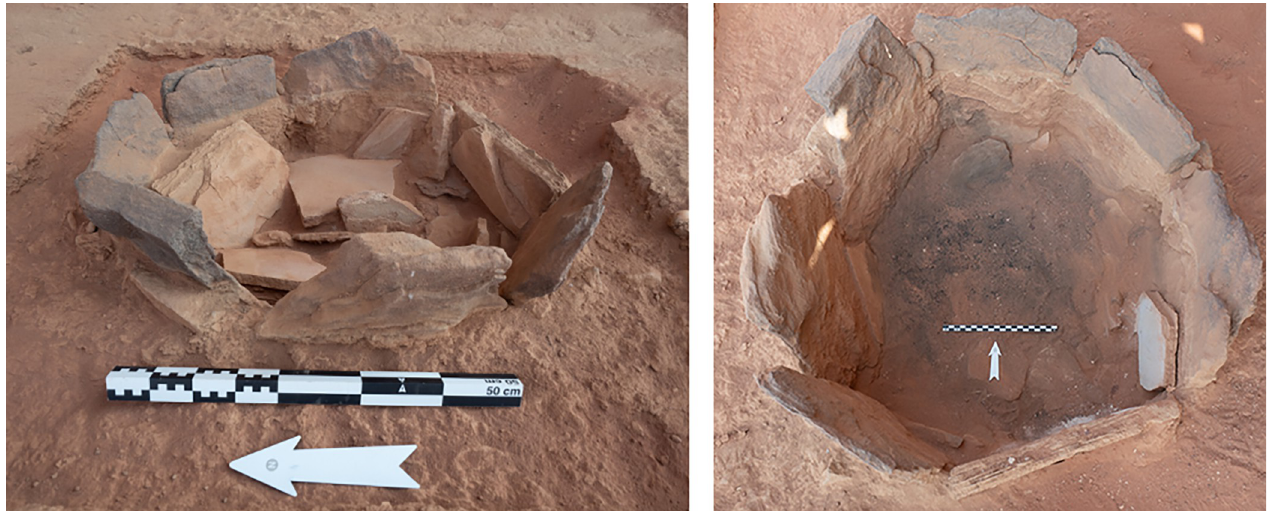
Fig 25. A Late Neolithic-early Chalcolithic hearth IDIHA-F-0011213.